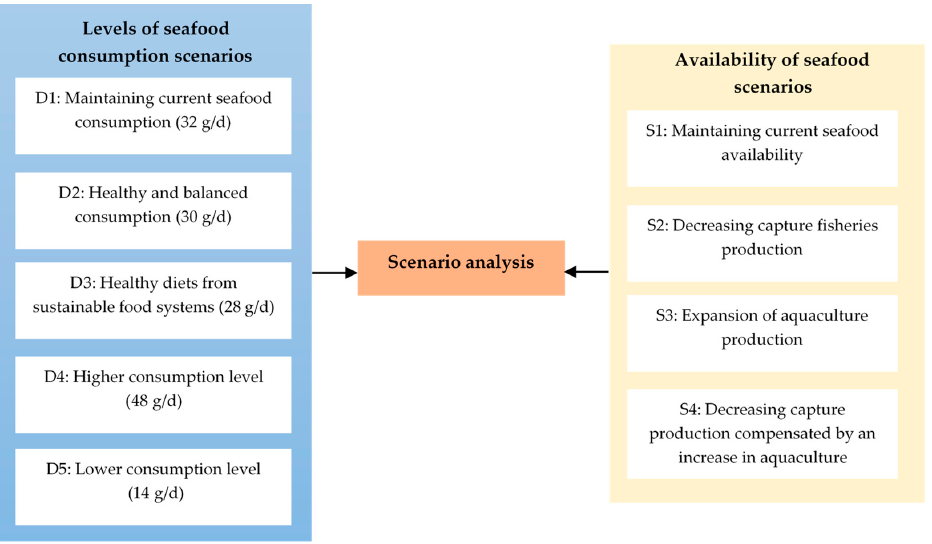
Figure 2. Schematic diagram of the scenario analysis considering different scenarios of Thai seafood availability and consumption.